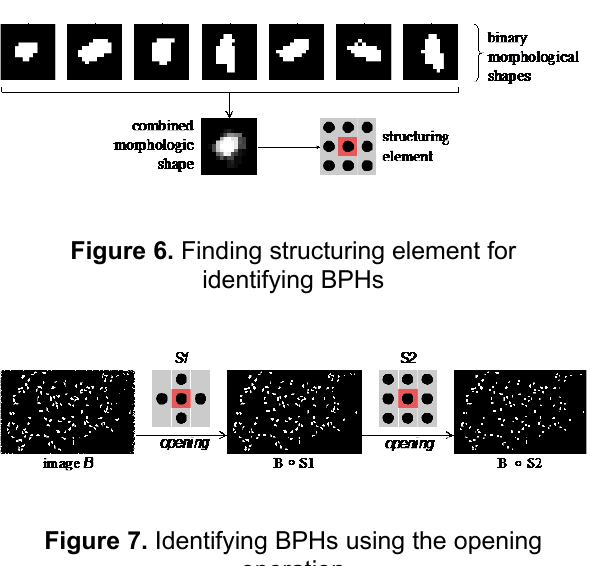
Figure 7. Identifying BPHs using the opening operation